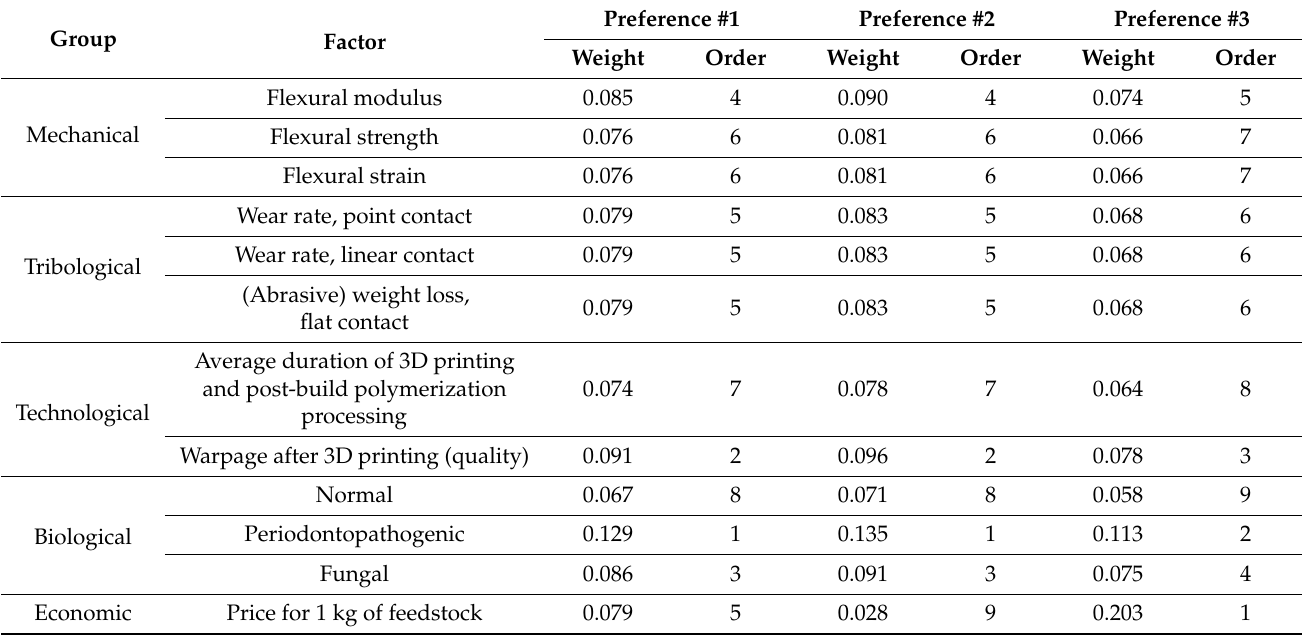
Table 15. Criteria